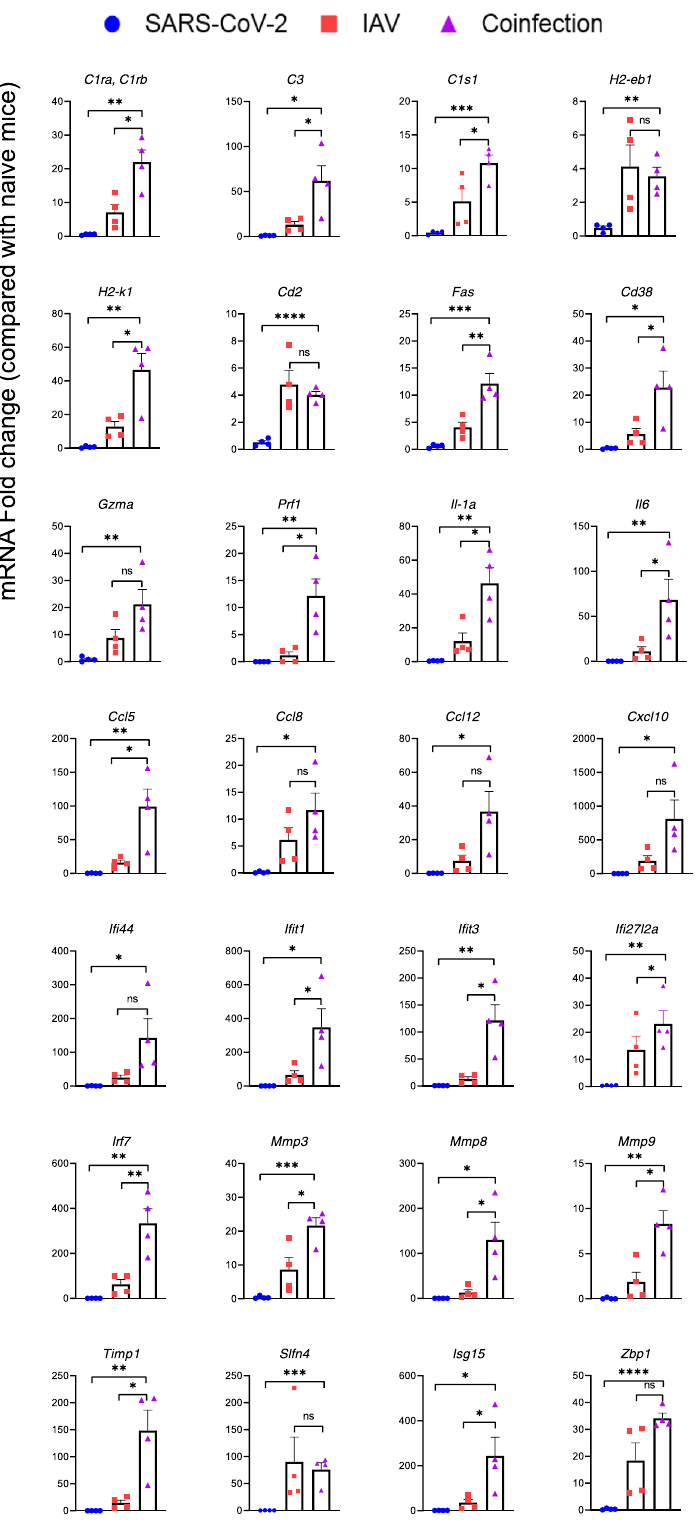
Fig. 3 Panel of in fl ammation-related genes with increased expression in the lungs of coinfected mice. Expression of various in fl ammation-related genes in the lungs. RNA was isolated from the lungs of K18-hACE2 mice at 4 dpIi/2 dpSi and analyzed by real-time qRT-PCR. Each symbol represents one mouse (4 per group). The Y axis represents the fold change in the infected mice compared with the naive mice. The column height represents the mean. The error bars represent the SE. * p < 0.05; ** p < 0.01; *** p < 0.001; **** p < 0.00002 Student ’ s t -test two tailed, Microsoft Excel